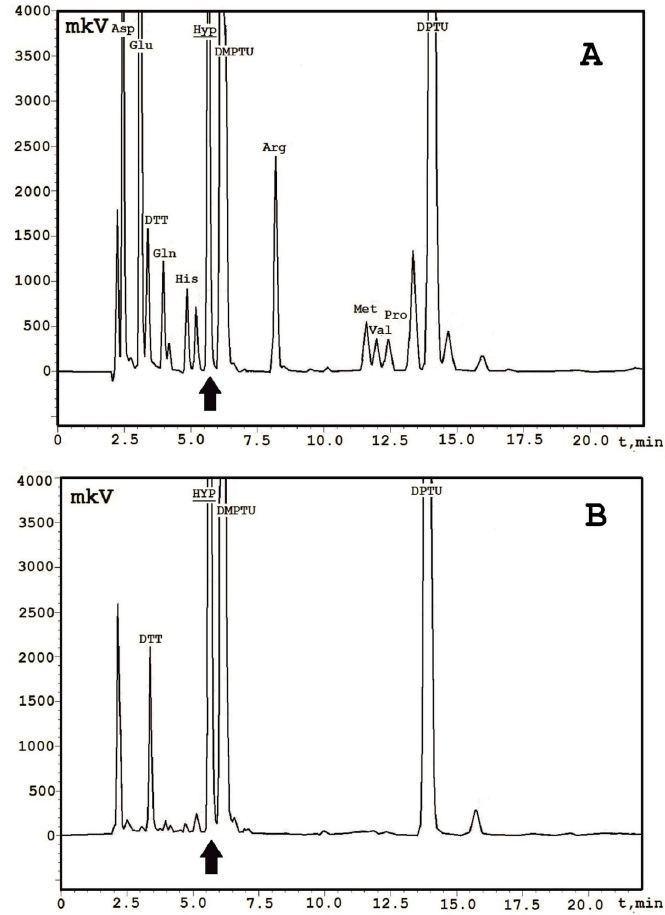
Figure 3. Identification of the hydroxyproline residue by the Edman automated sequencing. A —chromatographic separation of the PTH-amino acid derivatives generated on the 19th cycle of the EcAMP1-Hyp analysis, dithiothreitol (DTT); dimethylphenylthiourea (DMPTU); diphenylthiourea (DPTU). B —chromatographic separation of a PTH-amino acid derivative generated on the 1st cycle of an L -hydroxyproline analytical standard. A peak corresponding to the PTH-hydroxyproline is marked by the black arrow.